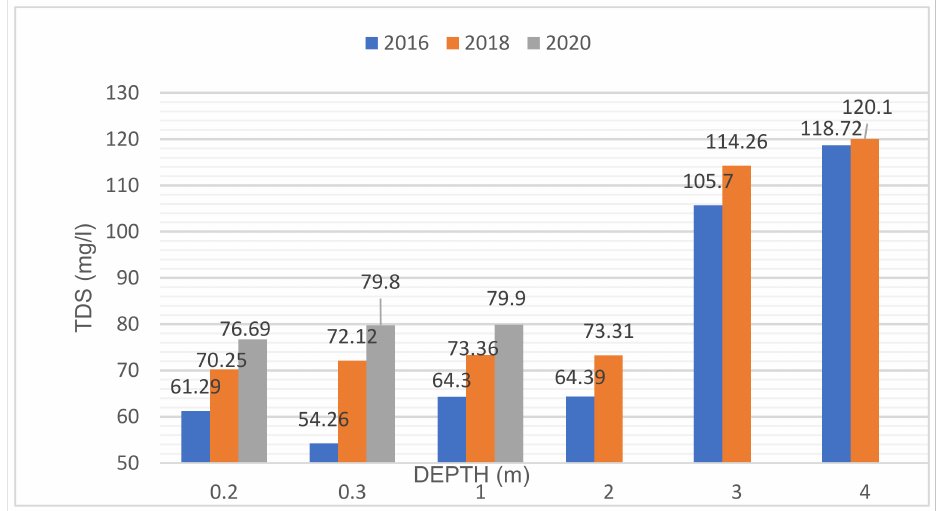
Figure 10. TDS levels at several depths of Lake Ocnei.